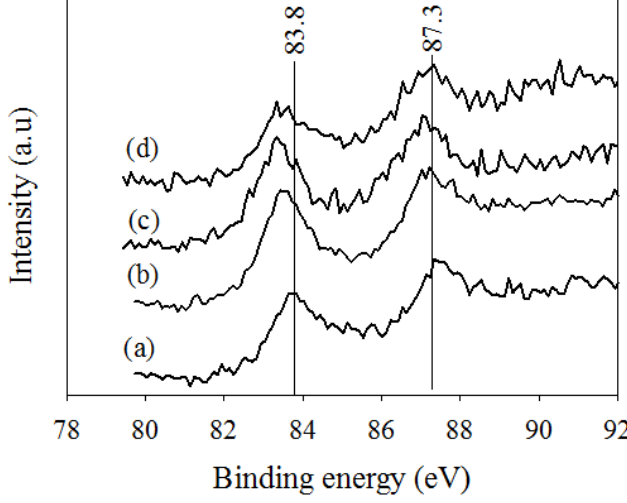
Figure 3. Au(4f) XP spectra of various Au/La 2 O 3 /Al 2 O 3 catalysts: (a) Au/La 2 O 3 /Al 2 O 3 (H); (b) Au/La 2 O 3 /Al 2 O 3 (S35); (c) Au/La 2 O 3 /Al 2 O 3 (S115); (d) Au/La 2 O 3 /Al 2 O 3 (G).